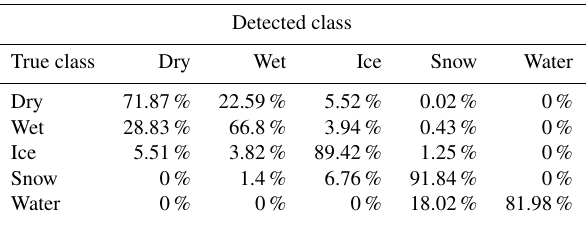
Figure 14. Examples of classification results with an NIR camera and NIR LEDs. The true classes are labeled under each image. The classification results are presented with colors. Table 7. Confusion matrix by the